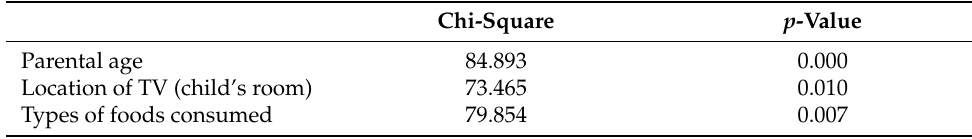
Table 7. Association between TV viewing duration, and parental age, location of TV (child’s room) and types of